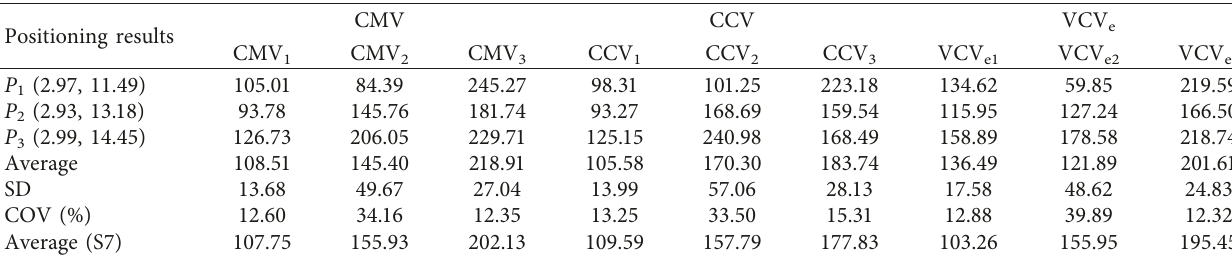
Figure 6: Results of vibration signal processing. (a) Waveforms of the original signal. (b) Frequency waveforms of the original signal. (c) Waveforms of the filtered signal. (d) Frequency waveforms of the filtered signal. Table 2: Compaction degree results at typical locations of section